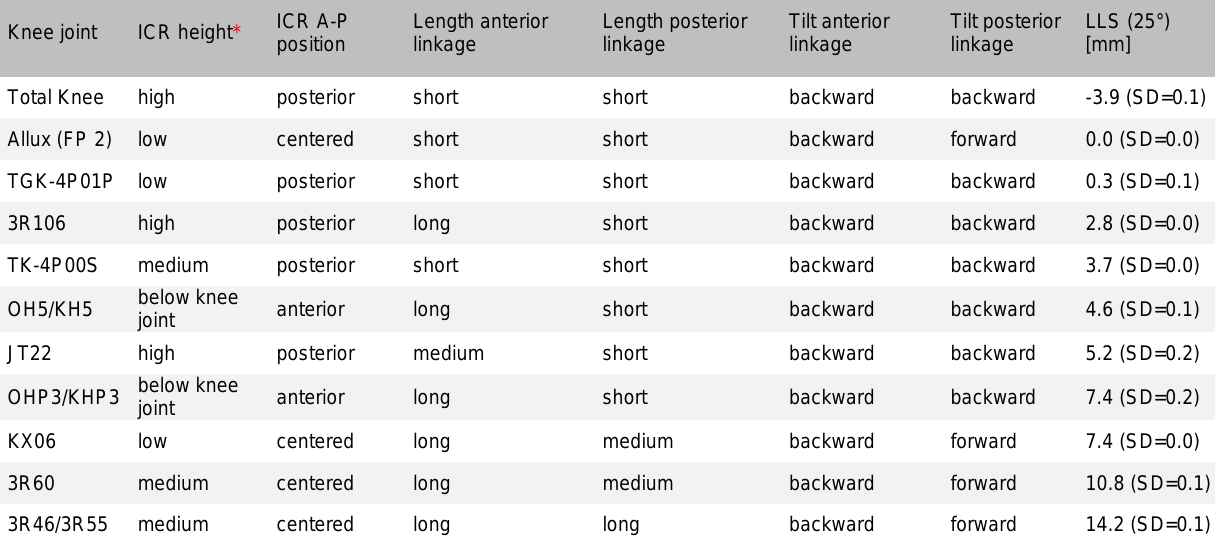
Table 2 : Evaluation of the geometric design of the polycentric knee joints investigated based on Figure 1 (visual comparison of proportions).